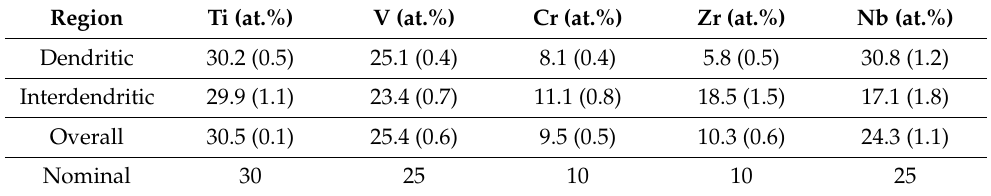
Table 1. EDS chemical analysis of the different regions in the as-cast alloy and the overall composition. Region Ti (at.%) V (at.%) Cr (at.%) Zr (at.%)